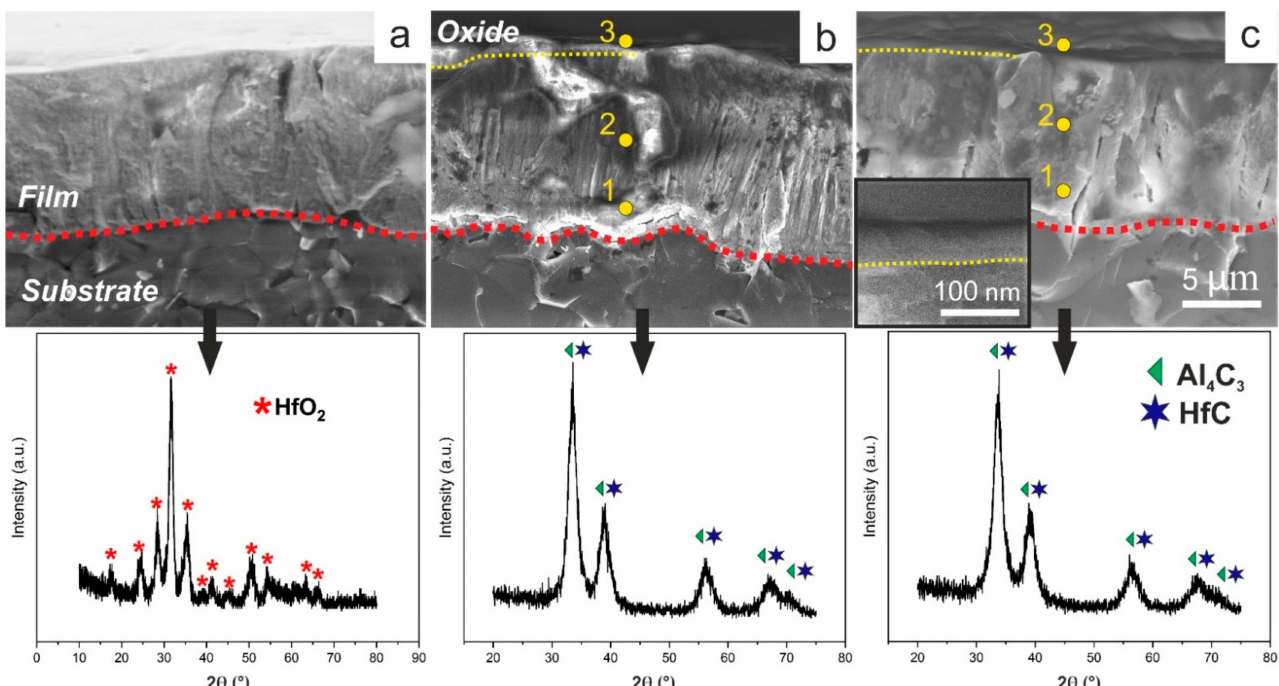
Figure 4. Cross-section images of HfC ( a ), Hf–Al–C with 5.6 at.% Al ( b ) and Hf–Al–C with 9.2 at.% Al ( c ) with the corresponding XRD patterns after the 140 min oxidation at 800 ◦